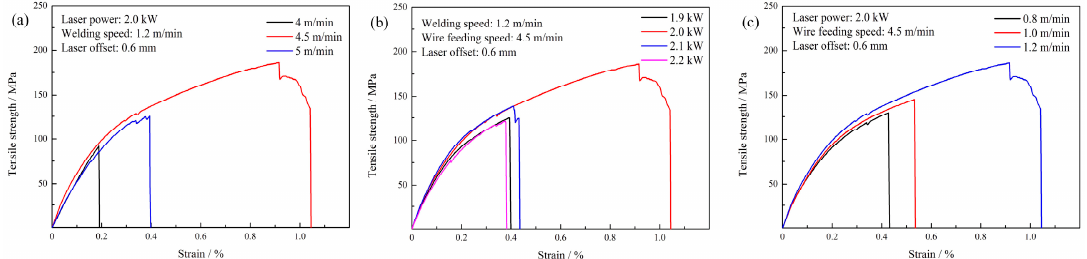
Figure 15. Stress ‐ strain curves of the tensile test with different welding parameters: ( a ) Wire feeding speed; ( b ) Laser power; ( c ) Welding speed.